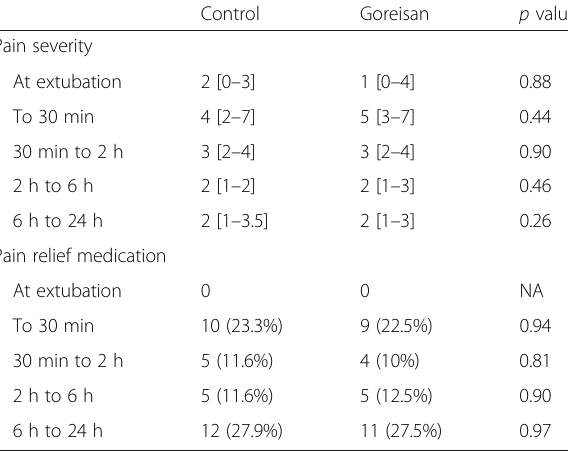
Table 7 Pain severity and pain relief